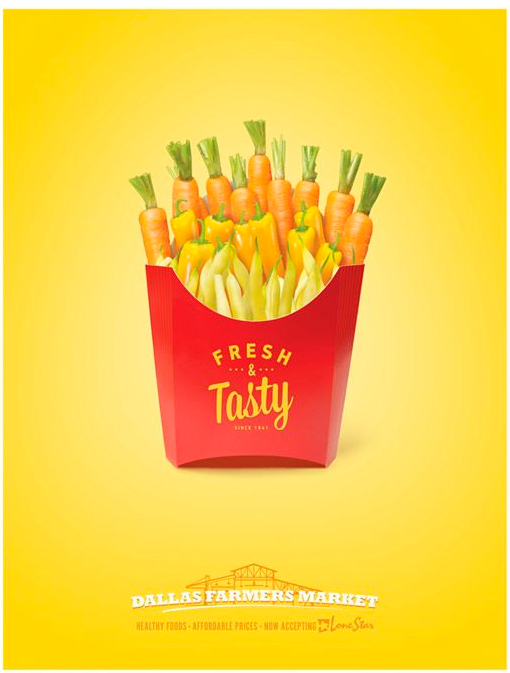
Figure A2. Advertisement for Dallas Farmers Market © Firehouse.